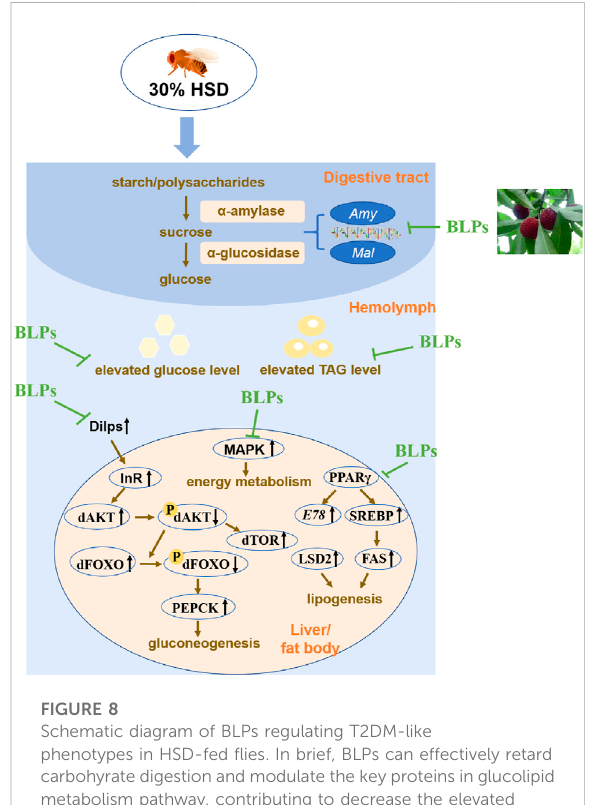
FIGURE 8 Schematic diagram of BLPs regulating T2DM-like phenotypes in HSD-fed fl ies. In brief, BLPs can effectively retard carbohyrate digestion and modulate the key proteins in glucolipid metabolism pathway, contributing to decrease the elevated glucose and TAG levels in HSD-fed fl ies. Dilps, Drosophila insulin- like peptides; InR, insulin-receptor; dAKT, protein kinase B in Drosophila ; dTOR, target of rapamycin in Drosophila ; dFOXO, forkhead box-O in Drosophila ; PEPCK, phosphoenolpyruvate carboxykinase; MAPK, mitogen-activated protein kinase; PPAR γ , peroxisome proliferator-activated receptor- γ ; SREBP, sterol- regulatory element bindingprotein;FAS,fatty acidsynthase; LSD2, lipid storage droplet